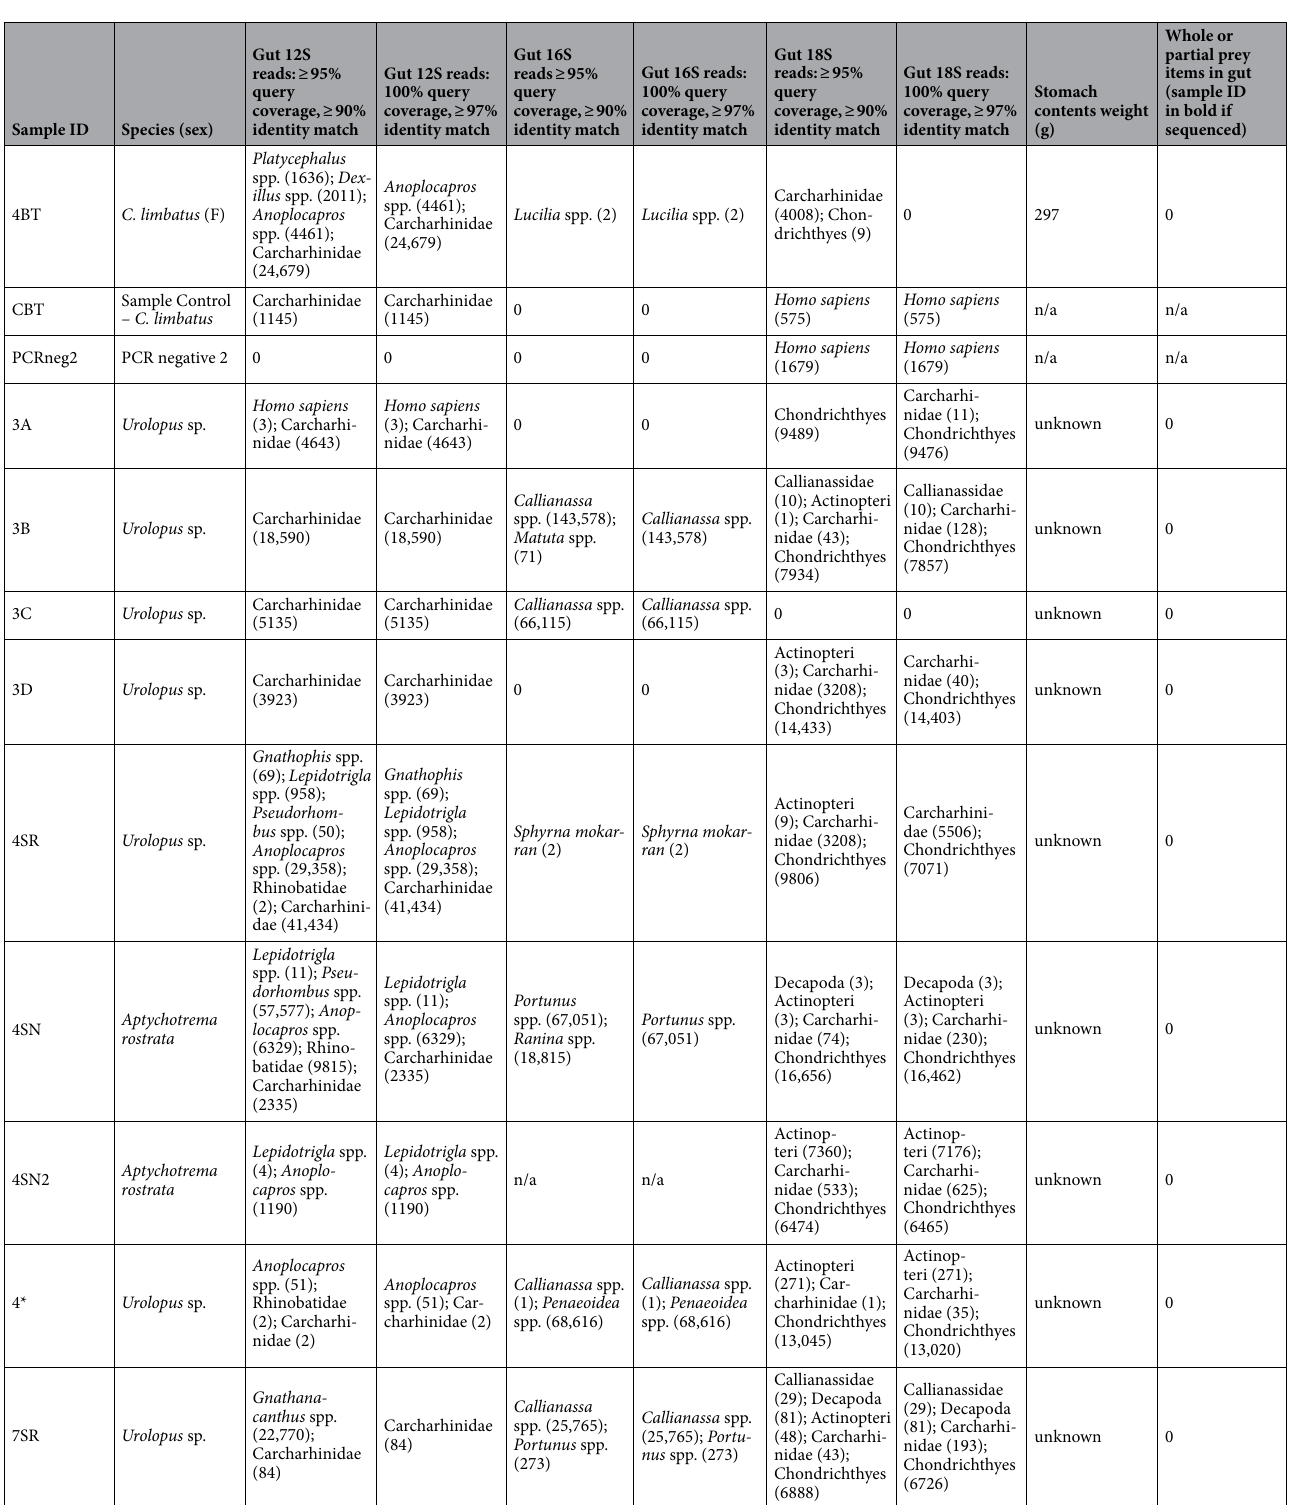
Table 1. Sample identification, species and sex (where identifiable) and the contents of their stomachs (‘gut’) determined via metabarcoding (to the closest taxonomic level) and through visual inspection. Prey items identified by metabarcoding assays are listed for each of two filtering stringencies per amplicon (see Methods). Values in parentheses after species designation show the number of reads observed for that taxon (values listed in red reflect ≤ 10 reads; ‘n/a’ indicates that the sample was not sequenced, while ‘0’ indicates no amplification of relevant taxa). Species IDs shown in bold are those taxa identified in both the predator and the prey’s digestive tract via metabarcoding, and likely reflect cross-contamination via the predator’s stomach